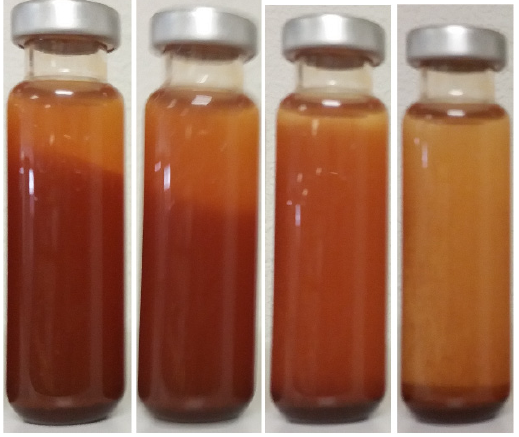
Figure 5. Oil-based nanofluid dispersion evolution with time.